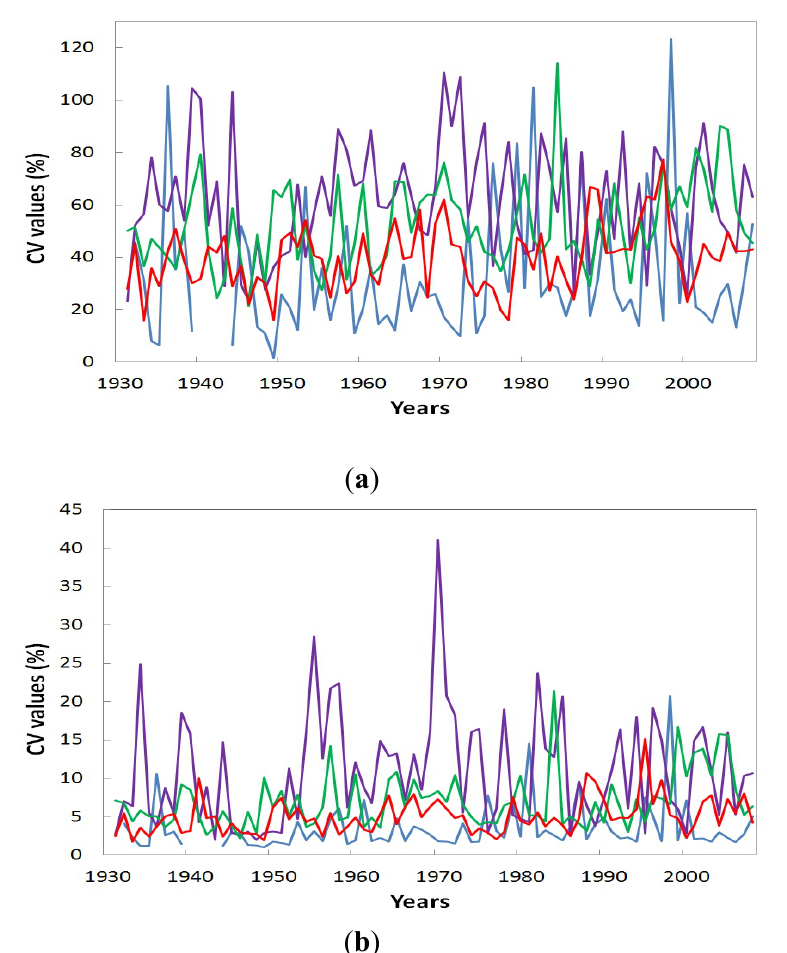
Figure 3. Temporal variability of the CV index in the Matawin River forested watershed ( a ) and the L’Assomption River agricultural watershed; ( b ) for the four seasons. Winter: blue curve; Spring: pink curve; Summer: green curve; fall: red